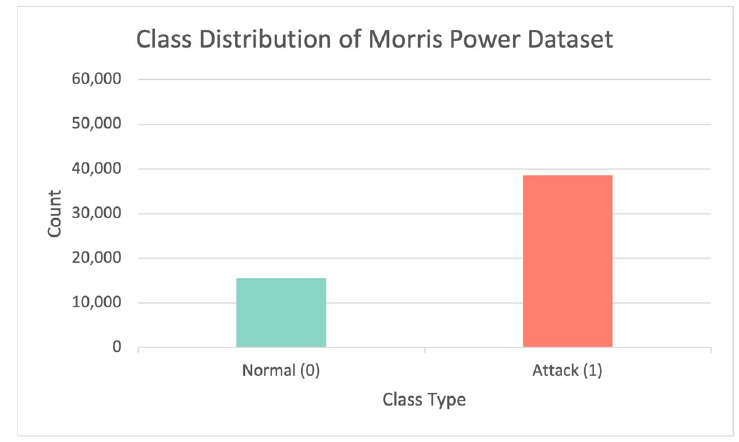
Figure 3. The percentage of attack records compared to normal instances in the Morris power da ‐ taset.